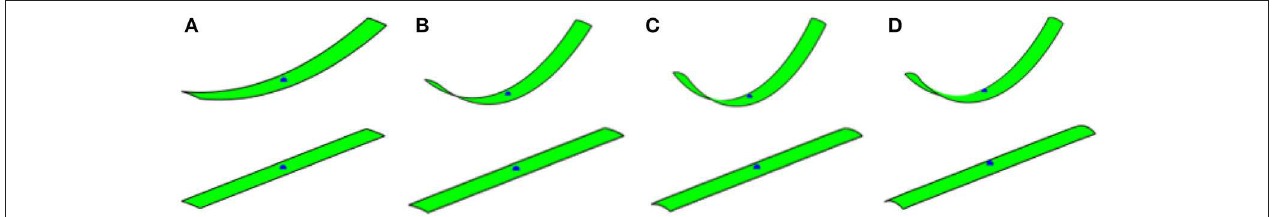
FIGURE 10 | Folding of 50 × 5rectangular plate, m 2 = 0. Top: with poisson’s effect; bottom: without poisson’s effect. (A) Electric field 25 MV/m; (B) electric field 43 MV/m; (C) electric field 68 MV/m; and (D) electric field 86 MV/m.